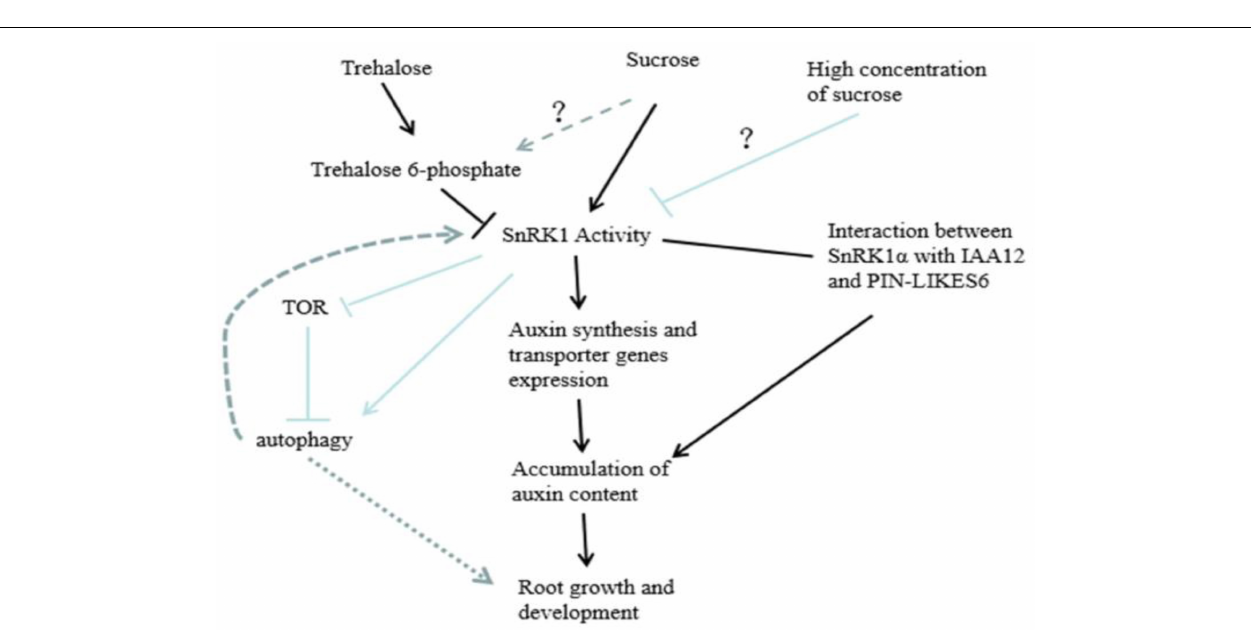
FIGURE 10 | Effects of different treatments on the expression of IAA1 2 and PIN-LIKES6 genes in peach roots. (A) Gene expression after short-term treatment. (B) Gene expression after long-term treatment. Error bars represent the averages of three biological replicates ± SD. Different letters represent differences between different lines in each gene. Significance was defined as P < 0.05.